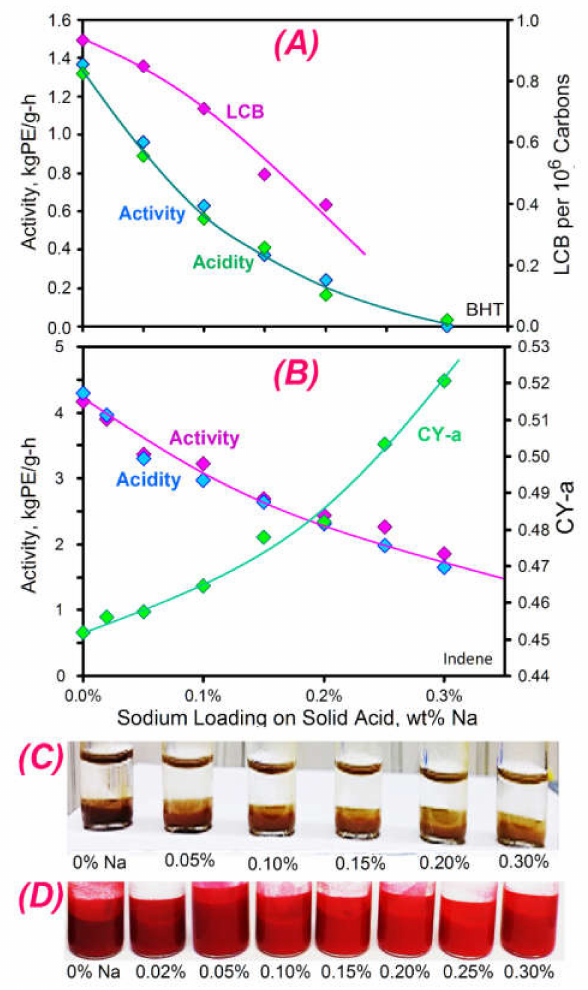
Figure 13. The effect of doping solid acids with sodium: ( A ) and ( C ) fluorided silica-alumina, ( B ) and ( D ) sulfated alumina. Colors show reaction with BHT ( C ) and indene ( D